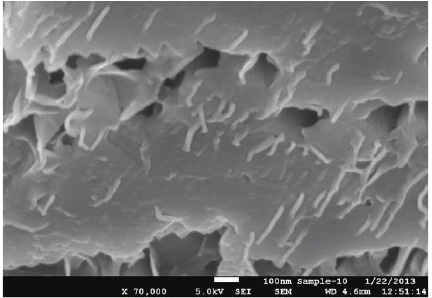
Figure 4: Scanning electron microscopy (SEM) image of the frac- tured surface on the nanocomposite showing uniform dispersion of modified CNF in the cementitious